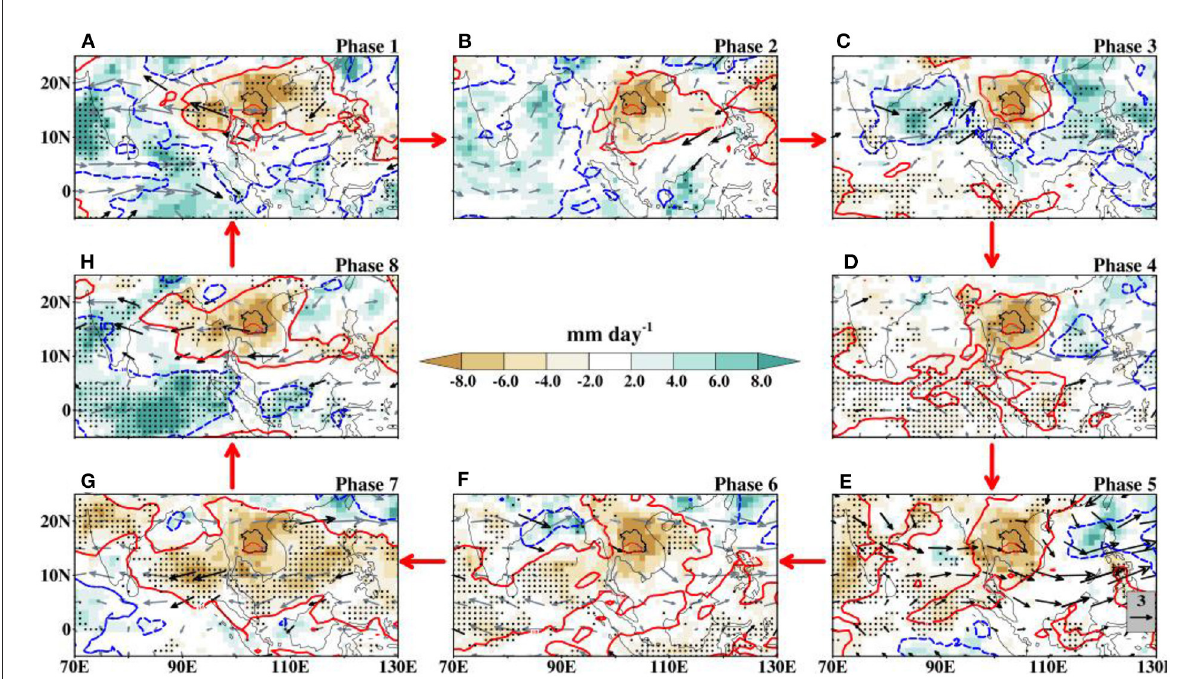
FIGURE10 (A–H) Composite evolution of anomalies of observed dry extreme rainfall events (shaded), OLR (blue and red contours; W m − 2 ), and 850 hPa wind (gray vectors, m s − 1 ) for the May-October season during the period 1997–2014 during active BSISO phases. The OLR contour starts at ± 10 Wm − 2 at an interval of 10 Wm − 2 . Only the significant vector anomalies are shown with solid black arrows while the statistically significant rainfall anomalies are indicated with dots. The significance statistic is at the 95% confidence